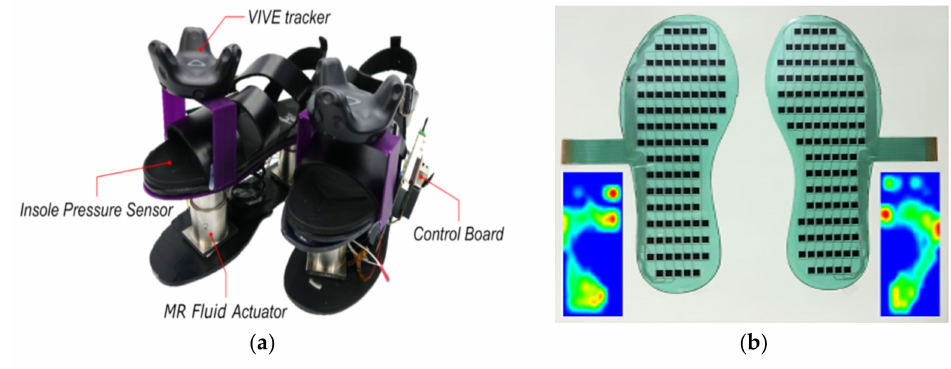
Figure 4. RealWalk haptic shoes ( a ); Sensor matrix ( b ) Adapted from [37]. Wei Wang et al. presented self-powered insoles integrated with piezoelectric poly vinylidene fluoride (PVDF) nanogenerators (NGs) and manufactured using 3D flatbed knitwear without seams for monitoring user gait and scavenging the walking energy [38]. The NGs were made by growing aluminum electrodes on the PVDF film. The characteriza- tion results for different forefoot, heel positions, and walking speeds provided a maximum open-circuit voltage of 41 V for a 168.1 µ W power (Figure